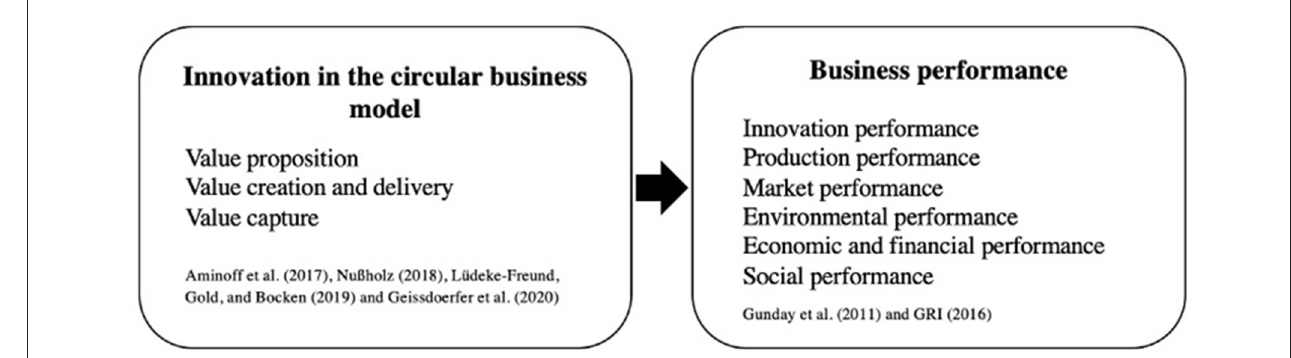
FIGURE 2 | Conceptual research